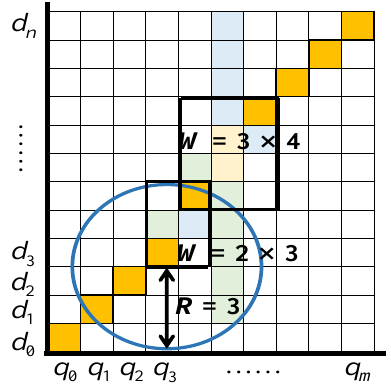
Figure 5. Schematic diagram of finding and confirming matching points.